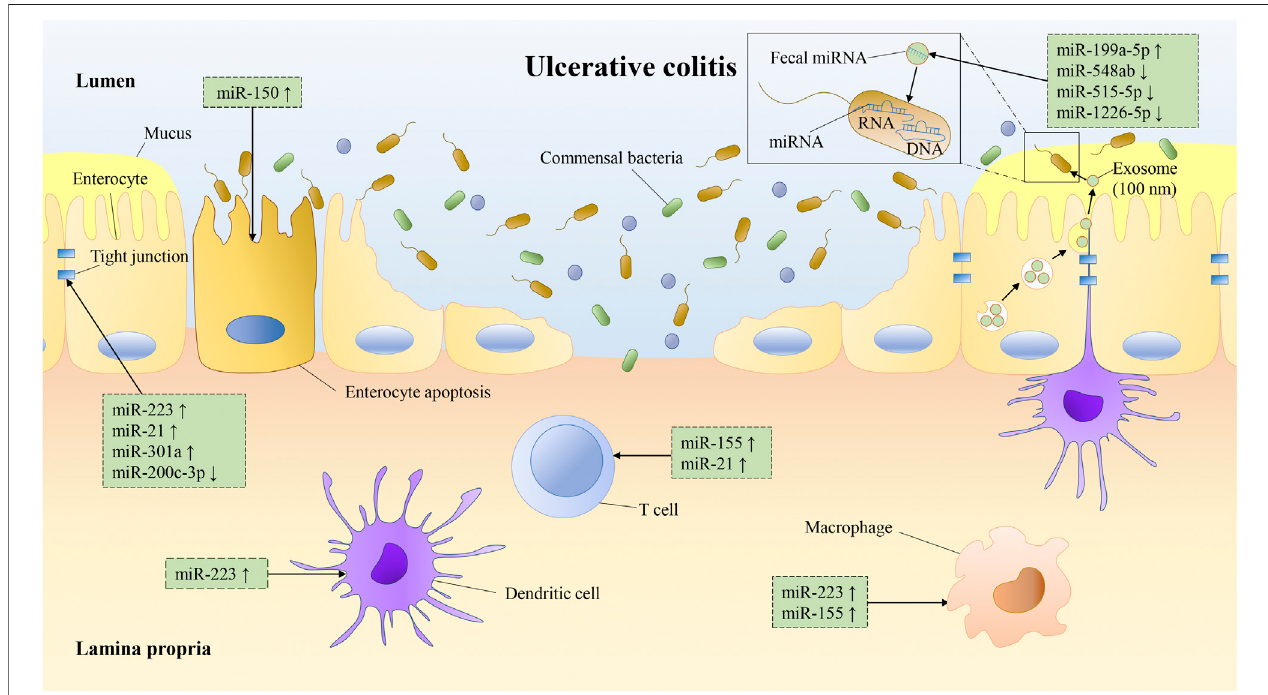
FIGURE 2 | miRNAs are involved in the occurrence and development of UC. miRNAs regulate the generation, differentiation, and function of multiple immune cells (e.g., macrophages, DCs, T-cell) (Murugaiyan et al., 2015; Zhou et al., 2015; Liu et al., 2016a; Wang et al., 2016a; Hou et al., 2017; Neudecker et al., 2017; Xu et al., 2017;Lietal.,2018;Weietal.,2020).miRNAsalsoaffectthephysicalbarrierofintestinaltractbyregulatingIEC ’ stightjunctionsandapoptosis(Bianetal.,2011;Vander Goten et al., 2014; Zhang et al., 2015; Wang et al., 2016b; He et al., 2017). In addition, miRNAs are secreted by IECs into the intestinal lumen through exosomes and regulate the bacterial growth (Liu et al.,